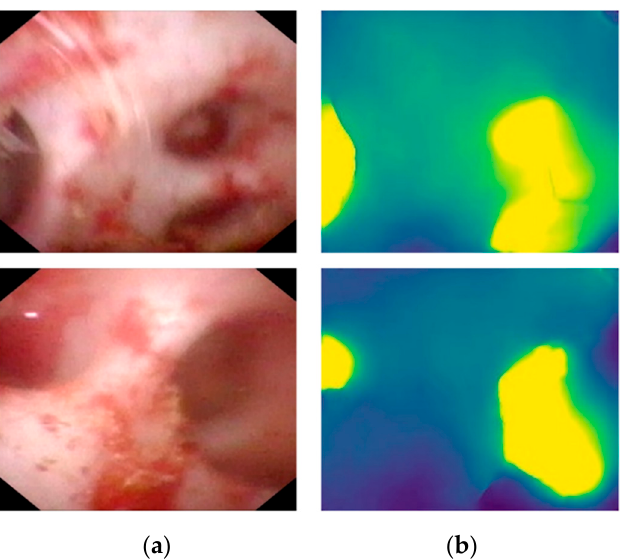
Figure 11. Example of the matching ambiguity. ( a ) shows ureteroscope image and ( b ) shows corre- sponding depth map. Two rows in ( a ) show different anatomical positions, but two rows in ( b ) show similar depth maps. ( b ) show similar depth